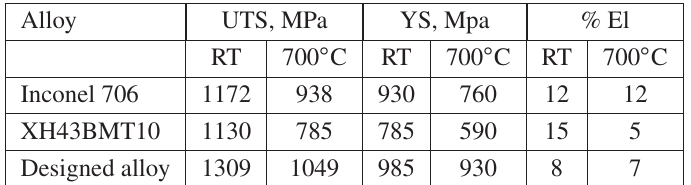
Table 6. Typical mechanical properties of Inconel 706, XH43BMT20 and designed super alloys at room temperature (RT) and 700 ı